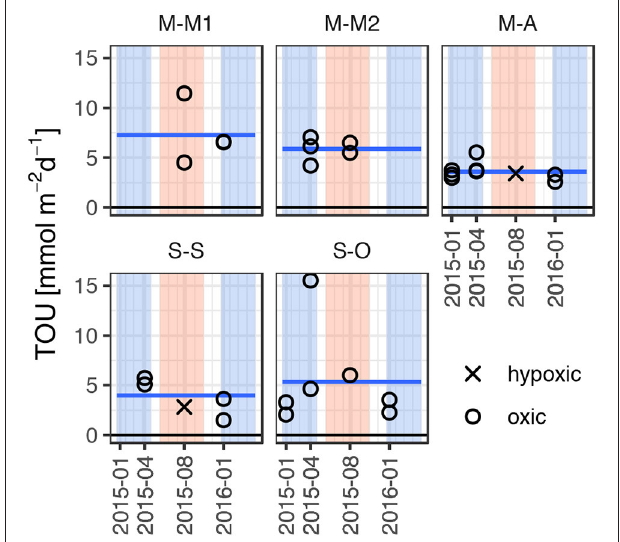
FIGURE 3 | Seasonal record of total oxygen uptake (TOU) rates in southern Baltic Sea sediments obtained via core incubation. Summer (June–October) and winter (January–April) season are highlighted by red and blue shaded areas, respectively. Horizontal blue lines represent the mean total oxygen uptake rate over all incubations for each site.